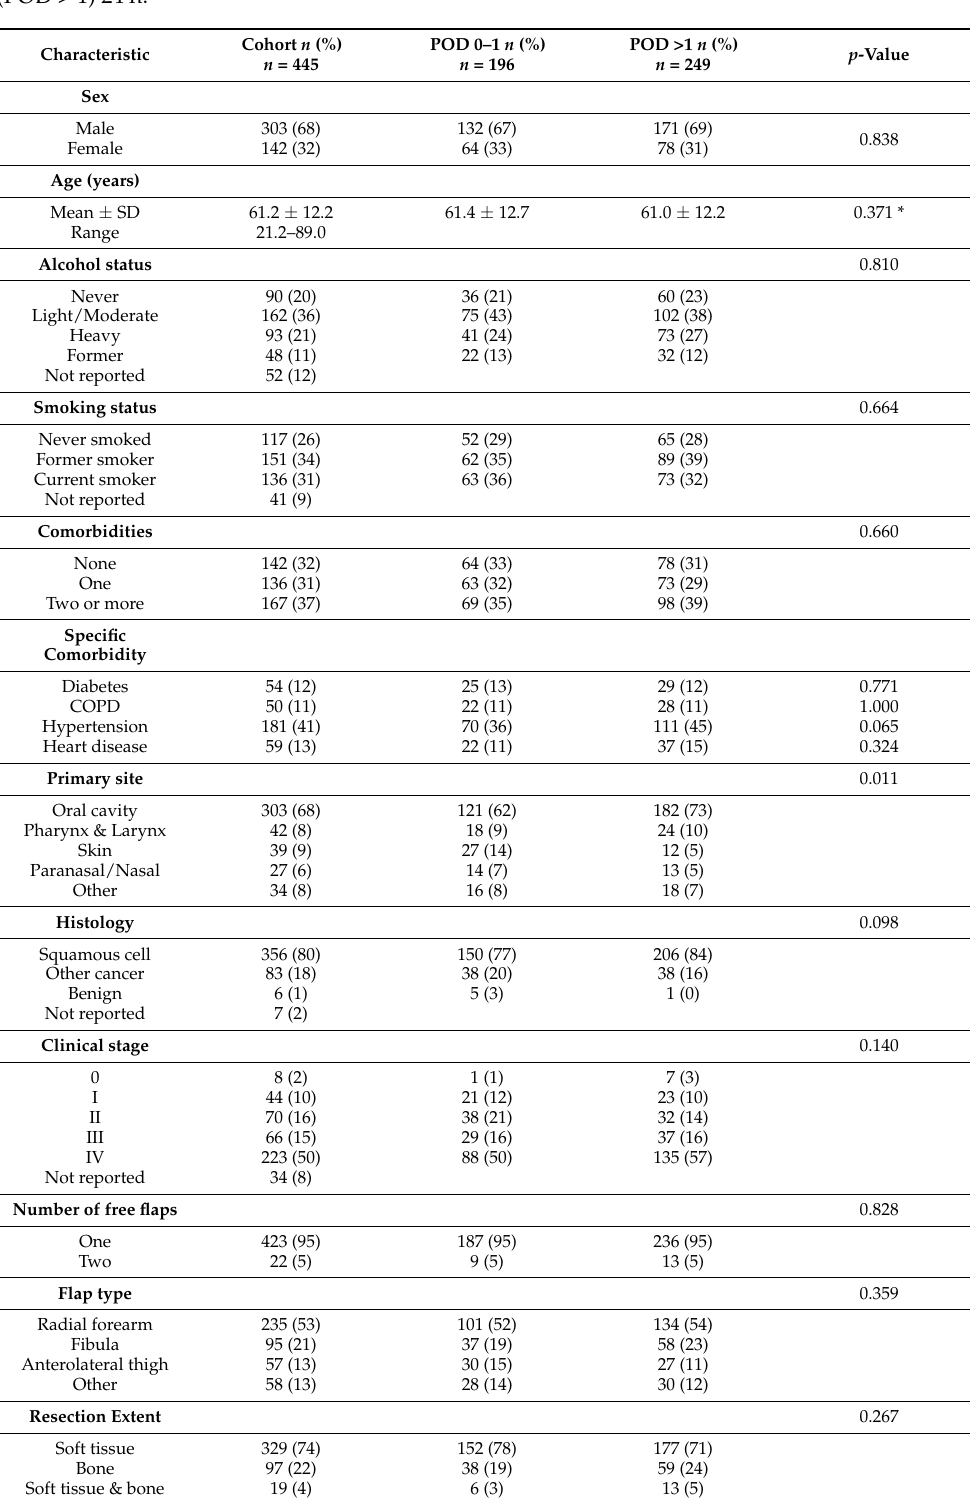
Table 1. Patient characteristics in for the cohort and for patients mobilized within (POD 0-1) or after (POD > 1) 24